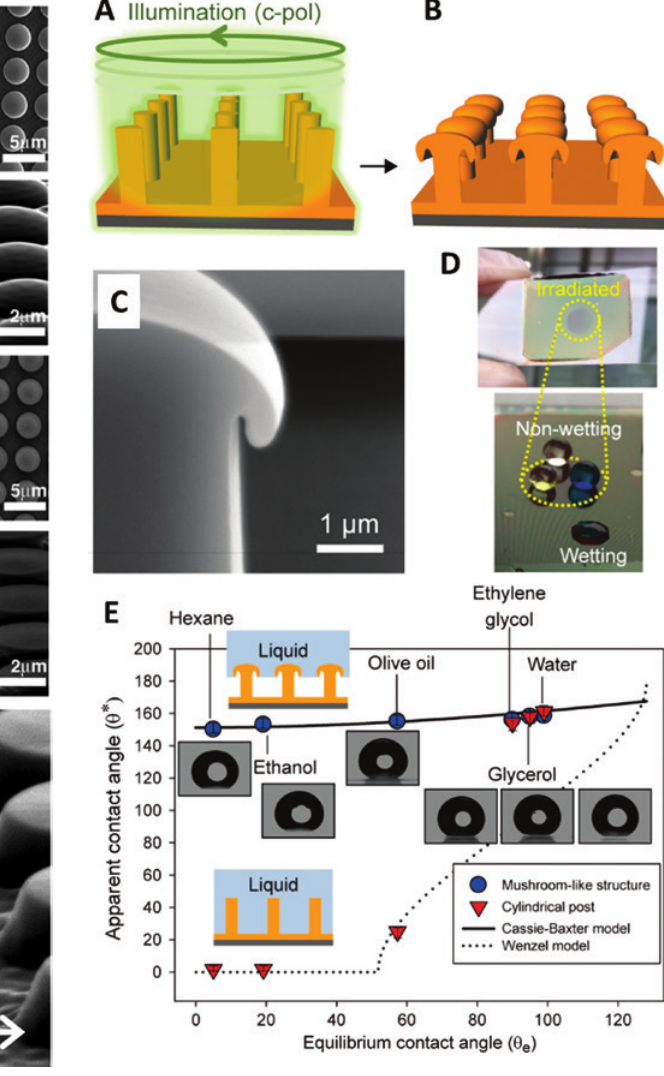
Figure 19: Mushroom-shaped azopolymer omniphobic surfaces. (A) and (B) Schematic representation of the light-induced recon- figuration of the pristine array of cylindrical imprinted micropillars. Circular polarized light is used to produce mushroom-like micro- structures. (C) SEM side view of a fabricated mushroom-like pillar.